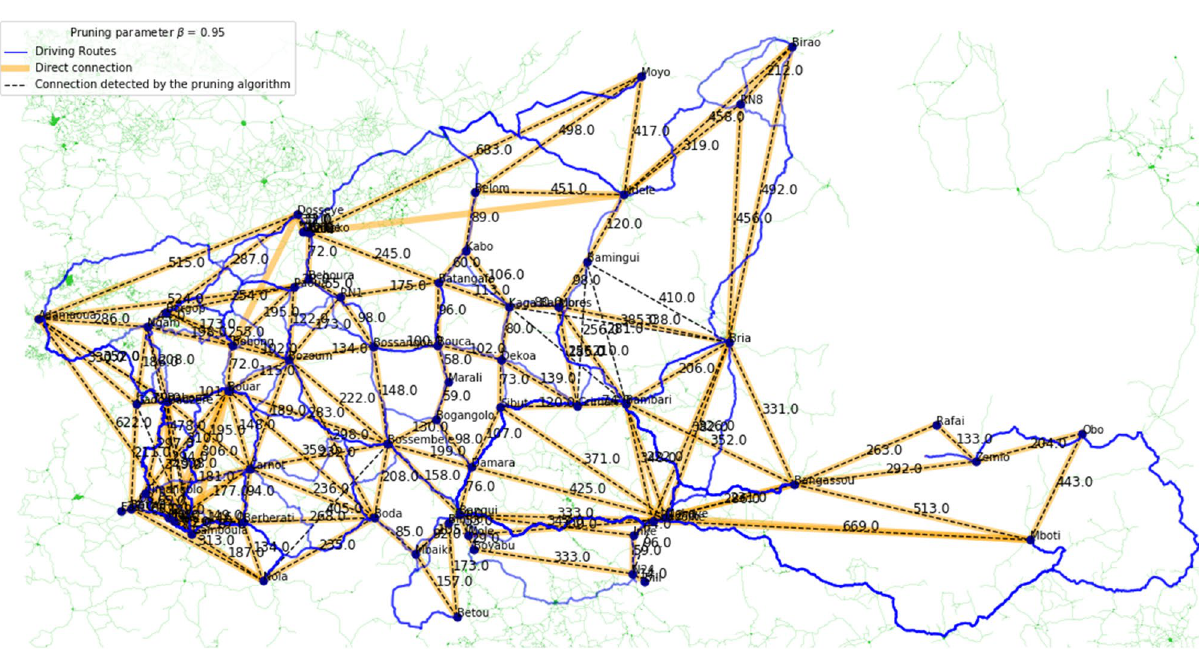
Figure 4. Connections of 62 locations in the Central African Republic with β = 0.95 .